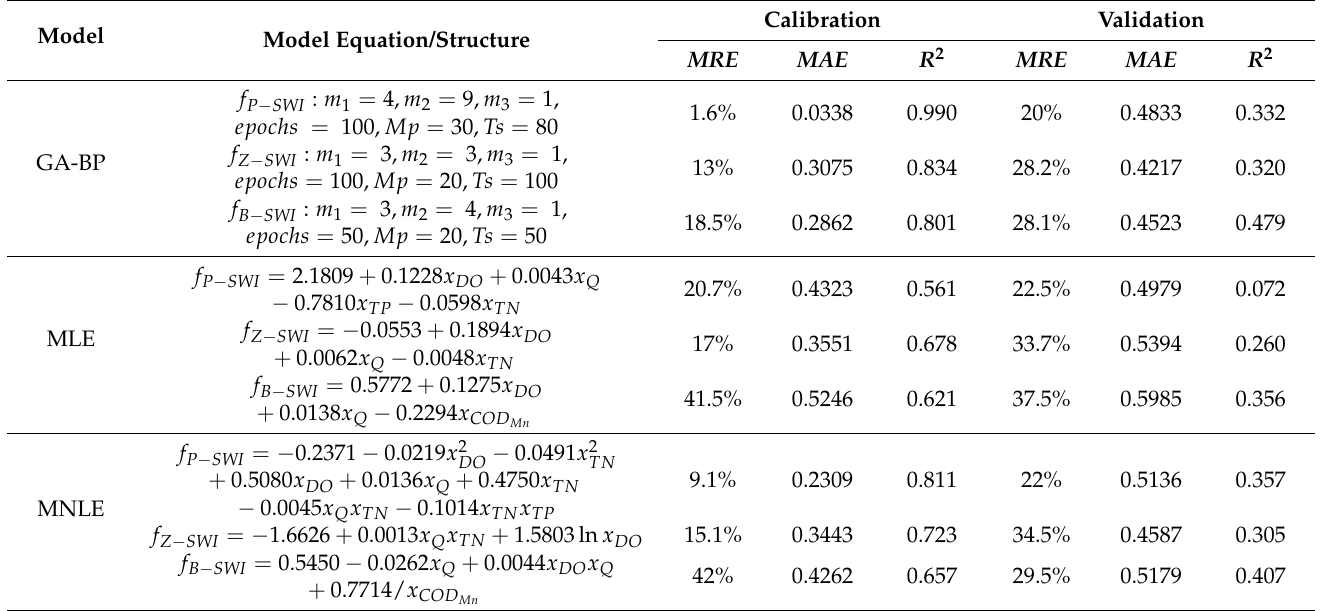
Table 6. Comparison of the MLE, MNLE, and GA-BP